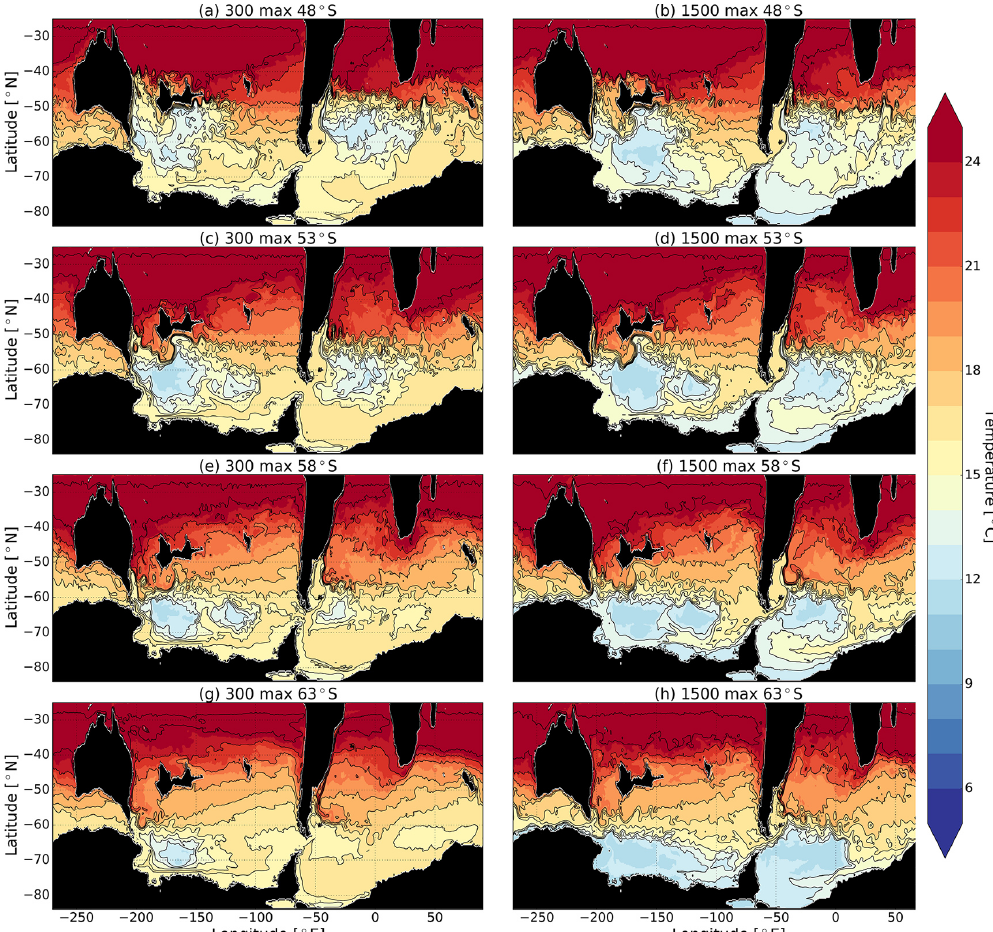
Figure 3. Annual mean sea surface temperatures (100m depth) of the Southern Ocean under the deepening of the Tasman Gateway from 300m (a, c, e, g) to 1500m (b, d, f, h) depth and wind stress shifts (from top to